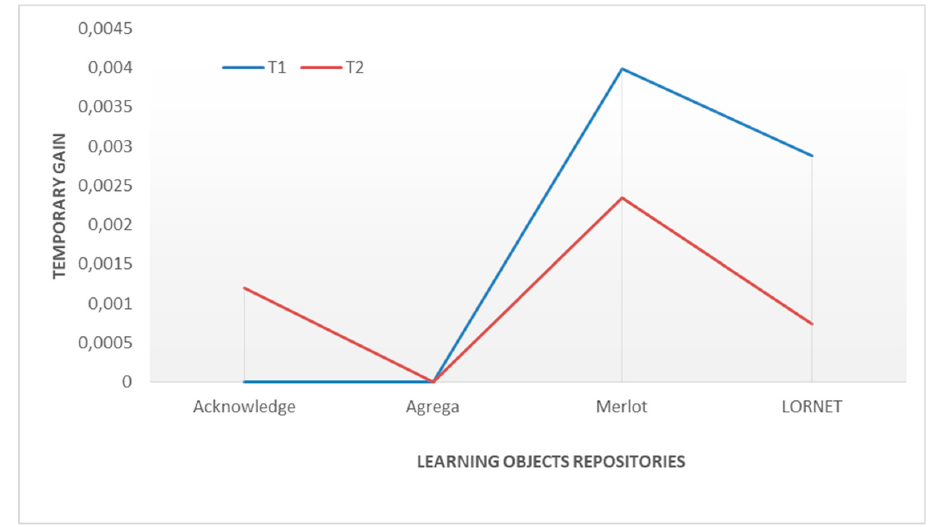
Figure 5. Temporary gain values for the same 60 queries at two different moments in time.